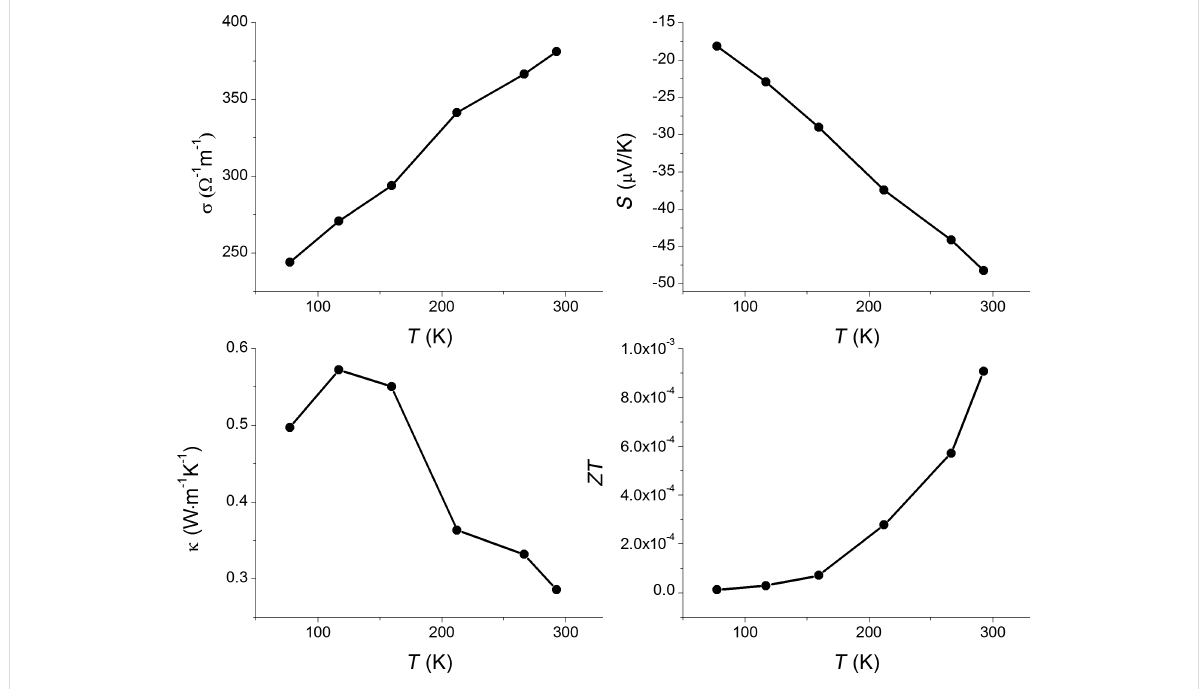
Figure 7: Thermoelectric properties of the S1 sample as a function of temperature. Solid lines are drawn to guide the eye.